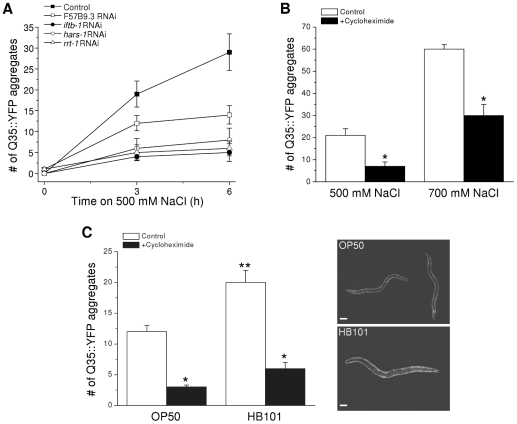
Effect of inhibition of protein synthesis on hypertonic stress-induced Q35::YFP aggregation.
A: Hypertonic stress-induced Q35::YFP aggregates in worms fed bacteria producing a nonspecific dsRNA (control) or bacteria producing dsRNA targeting eukaryotic translation initiation factors (F57B9.3 and iftb-1) or amino-acyl tRNA synthetases (hars-1 and rrt-1). The number of Q35::YFP aggregates was significantly (P<0.002) lower at both 3 and 6 h in worms fed dsRNA targeting iftb-1, hars-1 and rrt-1. Aggregates were reduced significantly *(P<0.004) at 6 h in worms fed RNAi targeting F57B9.3. (n = 15). B: Hypertonic stress-induced Q35::YFP aggregates in control worms and worms exposed to 500 µg/ml cycloheximide. Worms were exposed to cycloheximide in control growth medium for 15 min and then transferred to 500 or 700 mM agar containing cycloheximide. After 1 h worms were returned to control medium without the drug and aggregates quantified 2.5–3 h later. (n = 8–12). *P<0.0005 compared to untreated control worms. C: Left panel, hypertonic stress-induced Q35::YFP aggregation in worms fed OP50 or HB101 bacteria. Worms were exposed to 400 mM NaCl for 1 h. The protocol for cycloheximide treatment was the same as that described in B. (n = 14–27). *P<0.0001 compared to control worms without cycloheximide treatment. **P<0.0009 compared to OP50 fed worms. Right panel, representative fluorescent micrographs of OP50 and HB101 fed worms exposed to 400 mM NaCl for 1 h. Scale bar is 100 µm.